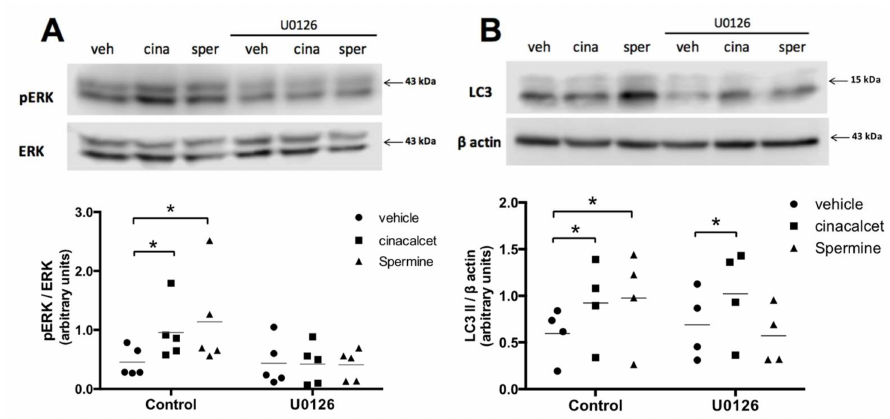
Figure 5. CaSR activation by spermine elevates autophagy through ERK1 / 2 in primary preadipocytes. ( A ) pERK / ERK and ( B ) LC3II levels were evaluated with or without pre-exposure to the upstream (MAPK) ERK1 / 2 phosphorylation inhibitor U0126 (10 µ M) in primary isolated human preadipocytes treated with the CaSR activators cinacalcet (2 µ M) or spermine (100 µ M) or vehicle. The images show representative blots for each condition, and graphs summarize the densitometry analysis. Bars represent mean ± SEM, * p < 0.05 for two-way ANOVA versus vehicle or vehicle + U0126 and Holm–Sidak’s multiple comparison post-hoc test, n =